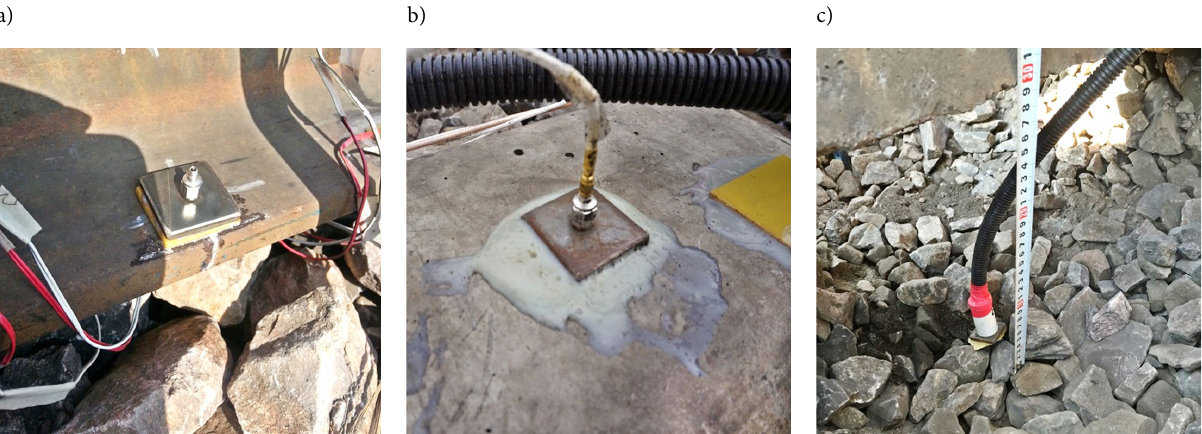
Figure 6. Arrangement of accelerometers for vertical vibration test: a – rail; b – sleeper; c – ballast at 300 mm